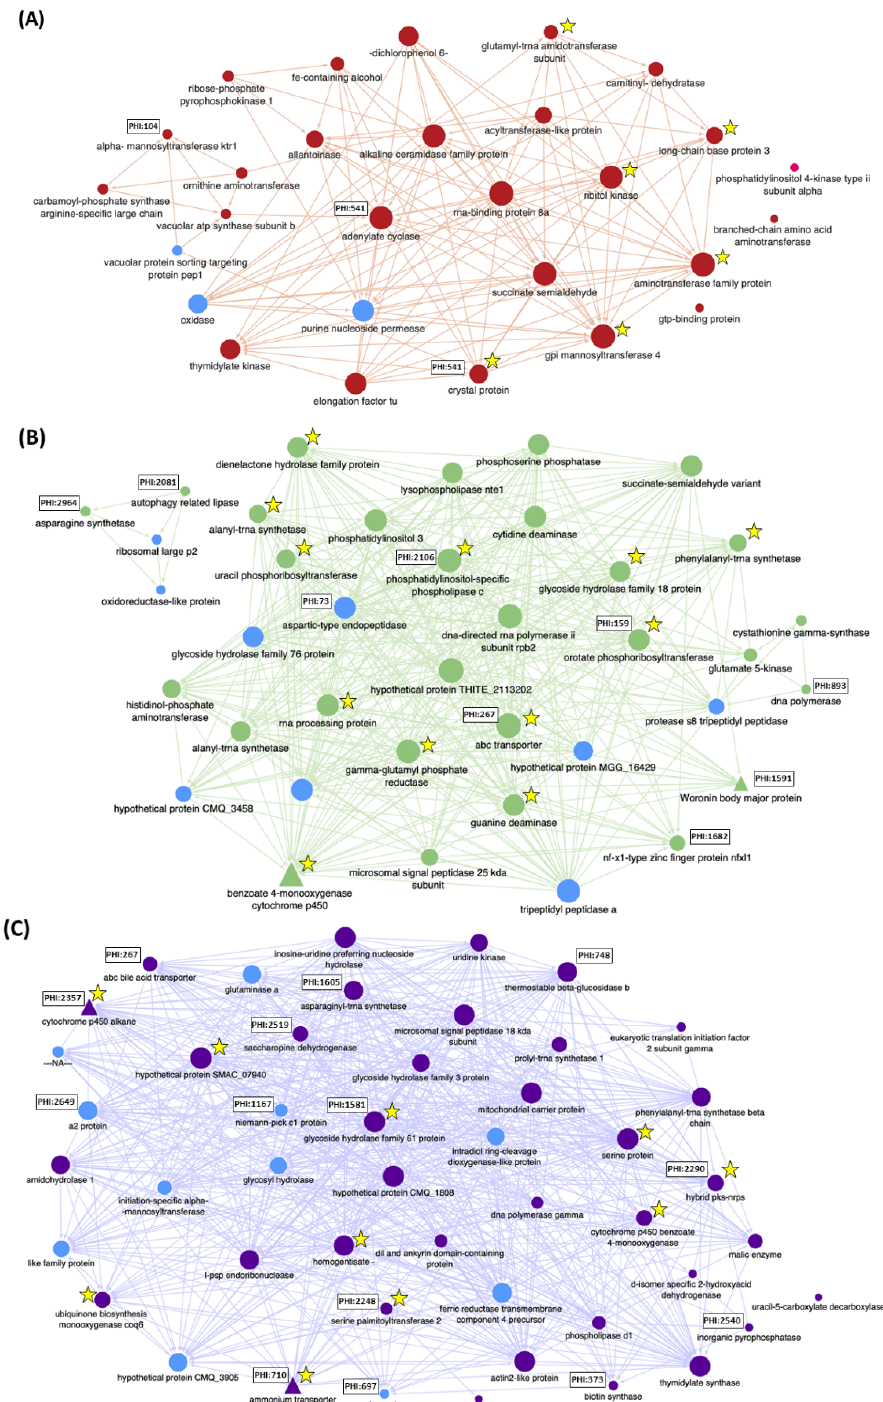
Figure 4. Interaction networks for selected genes in weighted-gene co-expression network analysis modules Darkred ( A ), Green ( B ) and Purple ( C ) that were associated with higher Ohiostoma novo- ulmi ssp. americana gene expression in susceptible (S) Ulmus americana . Interactions are shown for genes associated with KEGG pathway classes, along with genes predicted to encode a secreted protein with a signal peptide (light blue), and genes for which knockdown- or knockout mutants (triangles) were obtained and tested. Genes upregulated in S elms are identified by a star. PHI-base identifier is shown for genes with orthologs in the PHI-base curated database of genes involved in host-pathogen interactions. The size of the gene symbol (circle or triangle) is proportional to the number of interactions with other genes in the